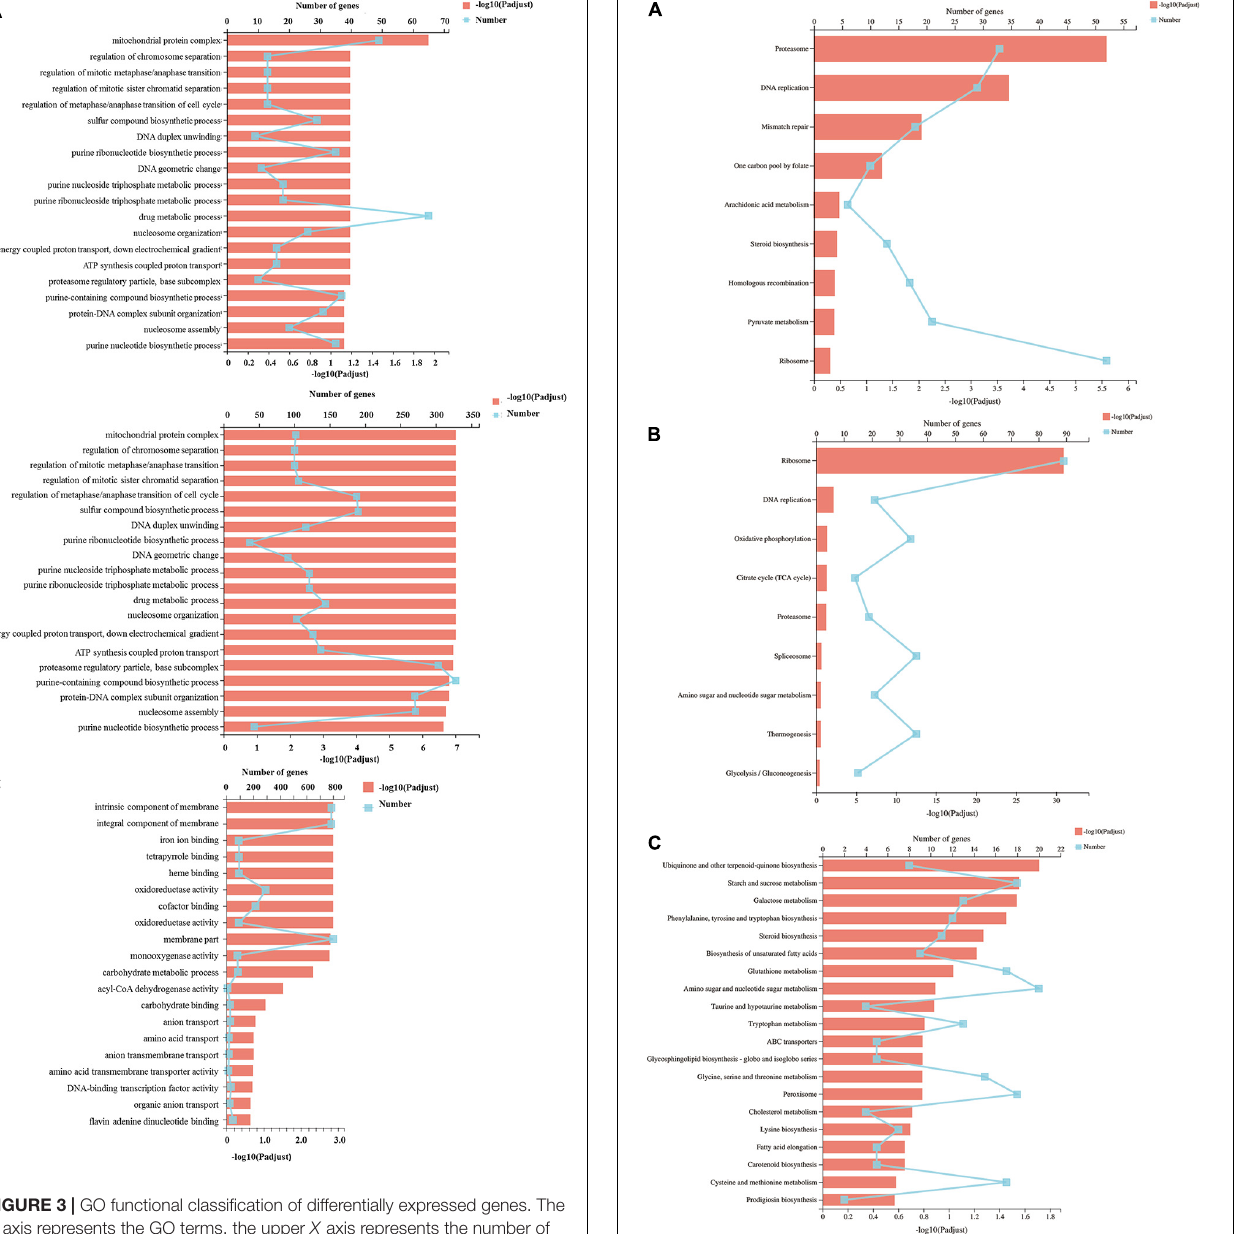
( Table 4 ). The expression of aryl-alcohol oxidase